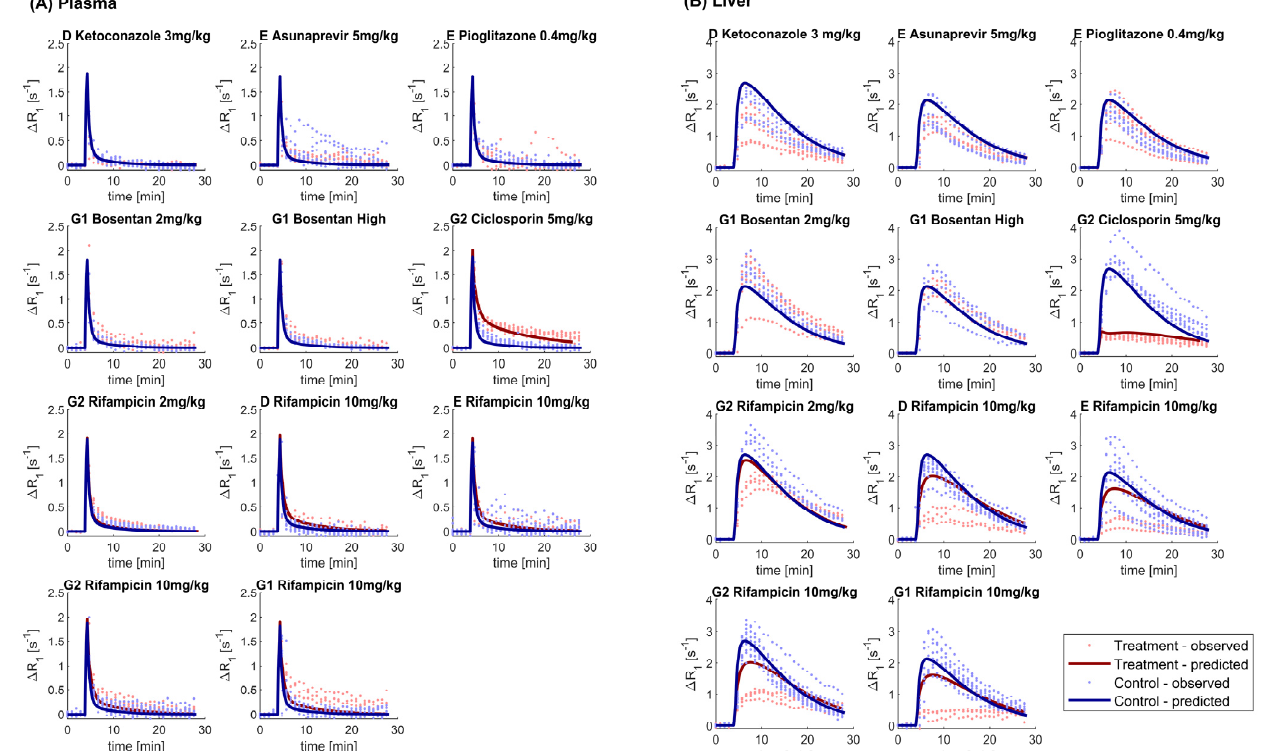
Figure 6. Predicted versus observed Δ R 1 -time profiles for different sites (D, E, G1, and G2) and per-